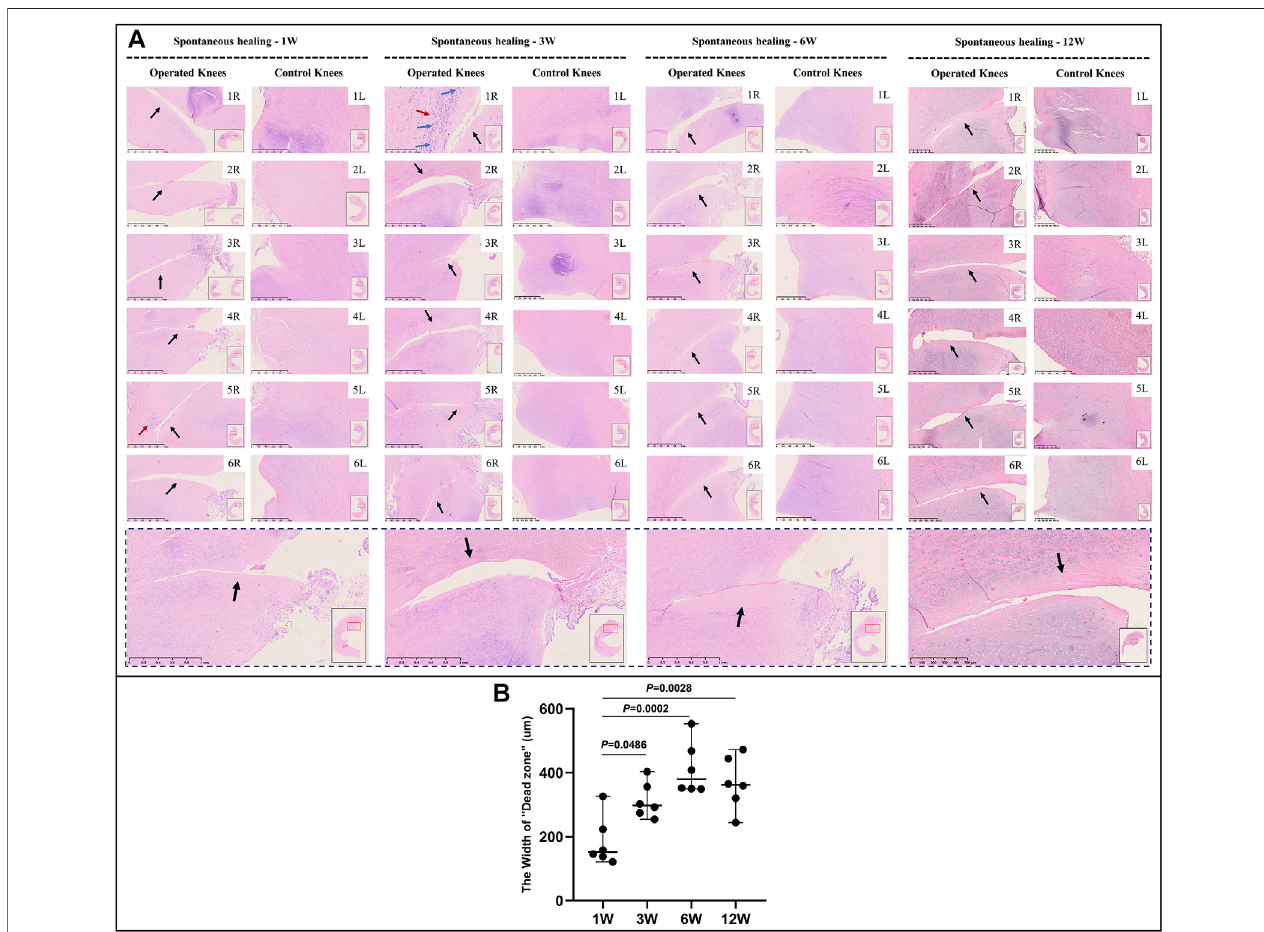
FIGURE 3 | HE staining and evaluation of cell death in mature menisci. (A) HE staining. (B) Evaluation of the width of the “ dead zone ” in torn mature menisci. The black arrows indicate the areaofcell death ( “ dead zone ” ).Thered arrows indicate cellclusters.The blue arrows indicate blood vessels.The lowerpanel ofimages witha black dotted-line border indicate representative specimens in the corresponding observation period. The width of the “ dead zone ” is expressed as median values with 95% CIs. The sample size for each group is six.